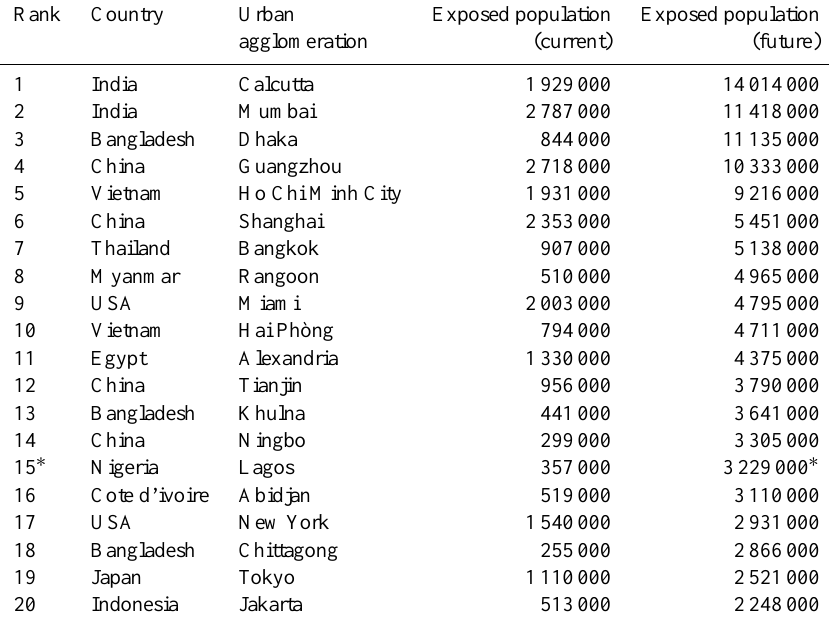
Table 2. Top 20 countries ranked in terms of population exposed to coastal flooding in the 2070s, including both climate change and socio- economic change and showing present-day exposure. (Source: Nicholls et al., 2008; OECD, Paris.) ( ∗ Highlight of Nigeria is by the authors.) Rank Country Urban Exposed population Exposed population agglomeration (current)